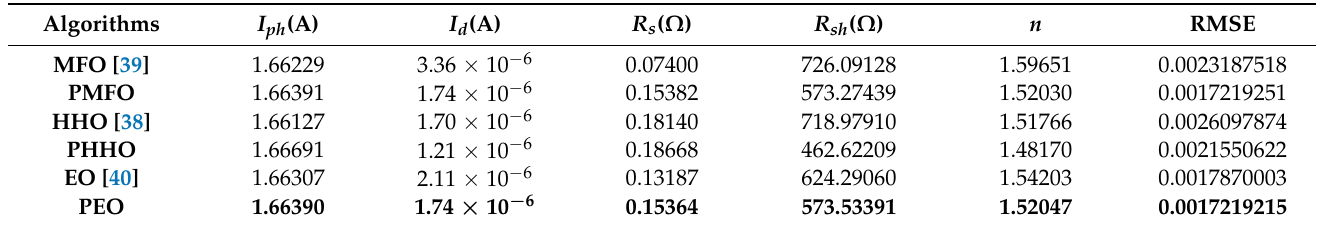
Table 7. Comparison under the extracted parameters and the corresponding RMSE of STM6.